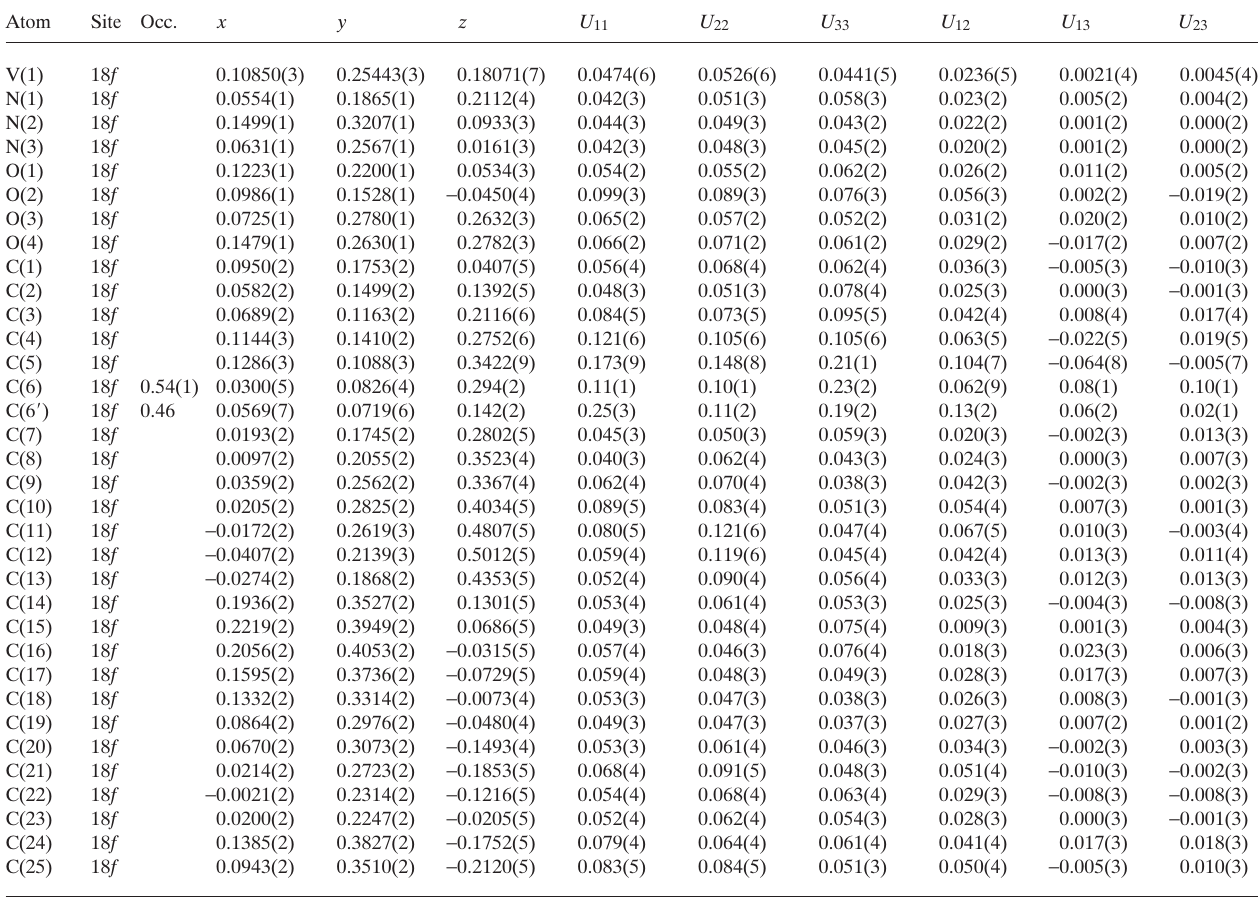
Table 3. Atomic coordinates and displacement parameters (in Å 2 ) .